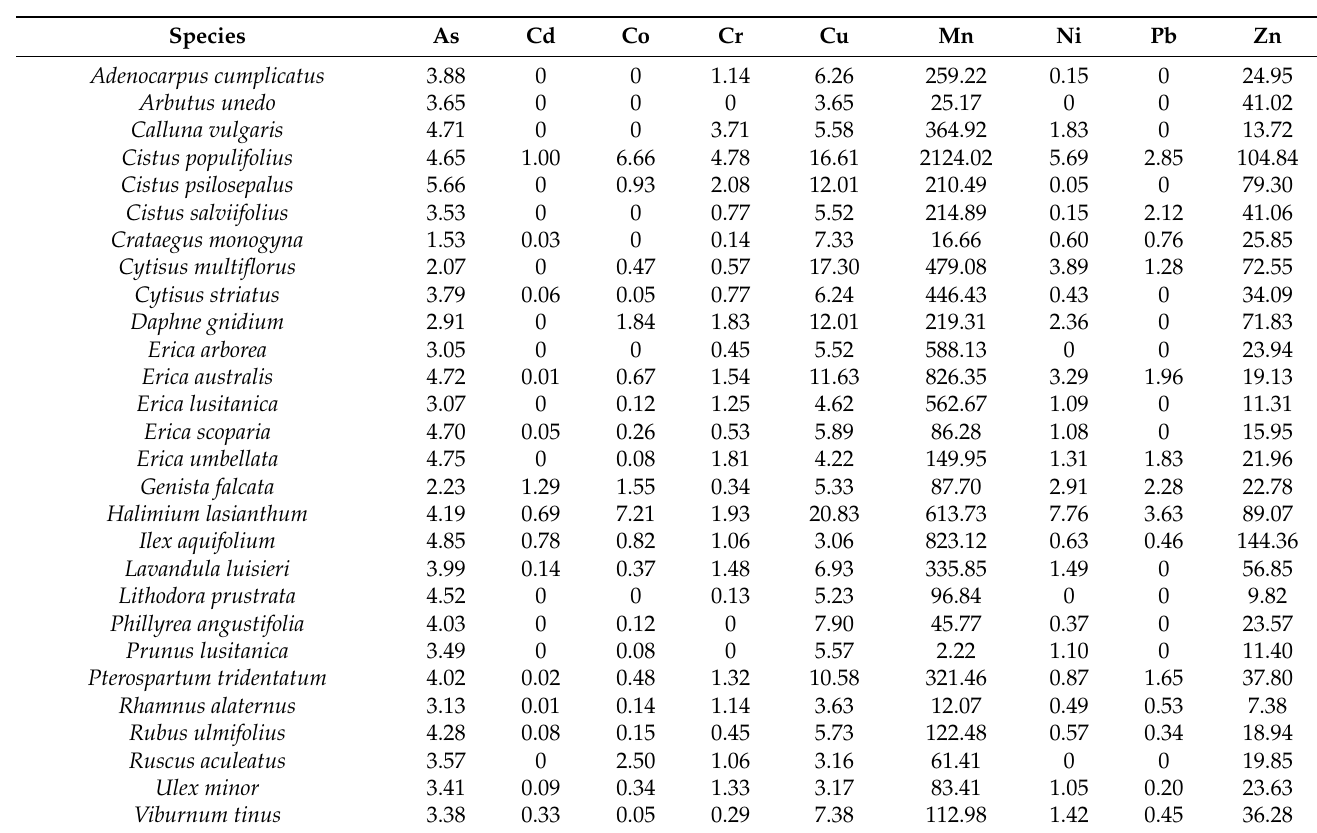
Table 2. Minor elements